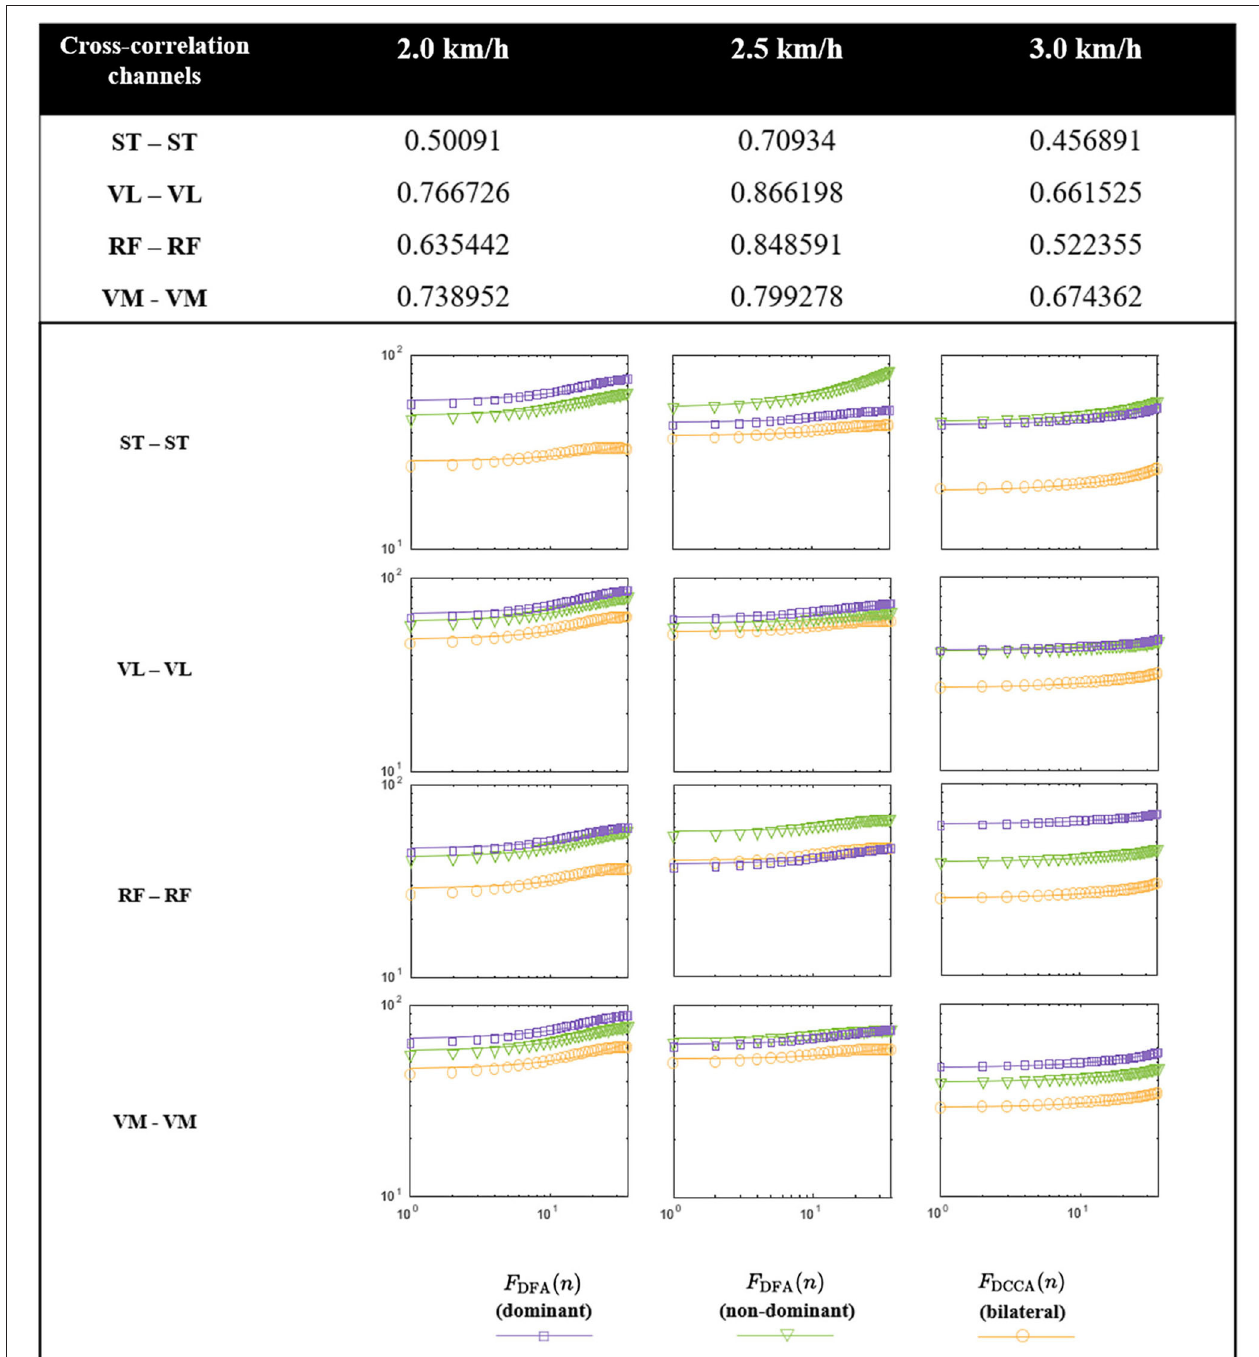
FIGURE 6 | Detrended cross-correlation analysis (DCCA) results across three predefined speeds. The table above describes four muscle channels and assessment of the muscle activities contribution, and the panel below shows the cross-correlation analysis results for corresponding muscle pairs.